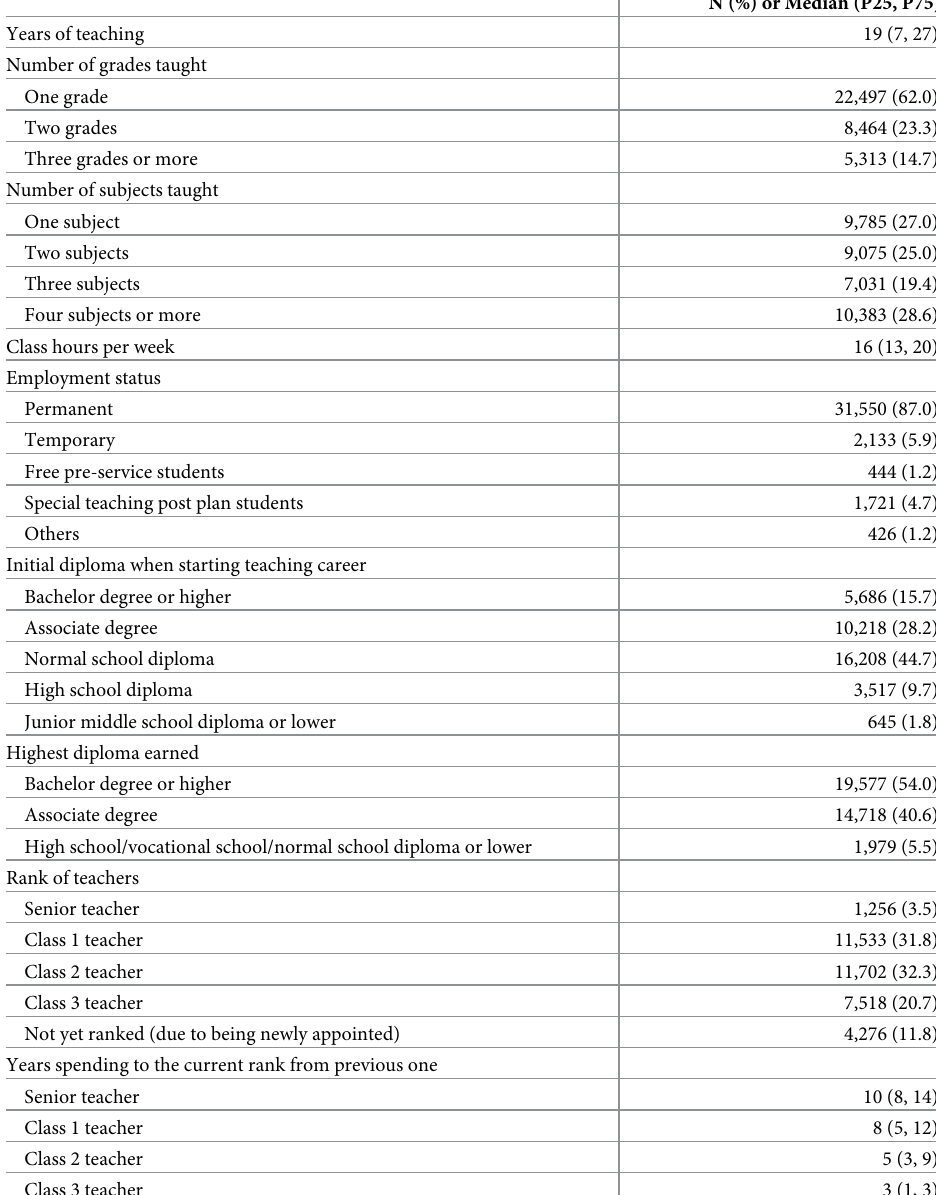
Table 5. Professional characteristics of the total